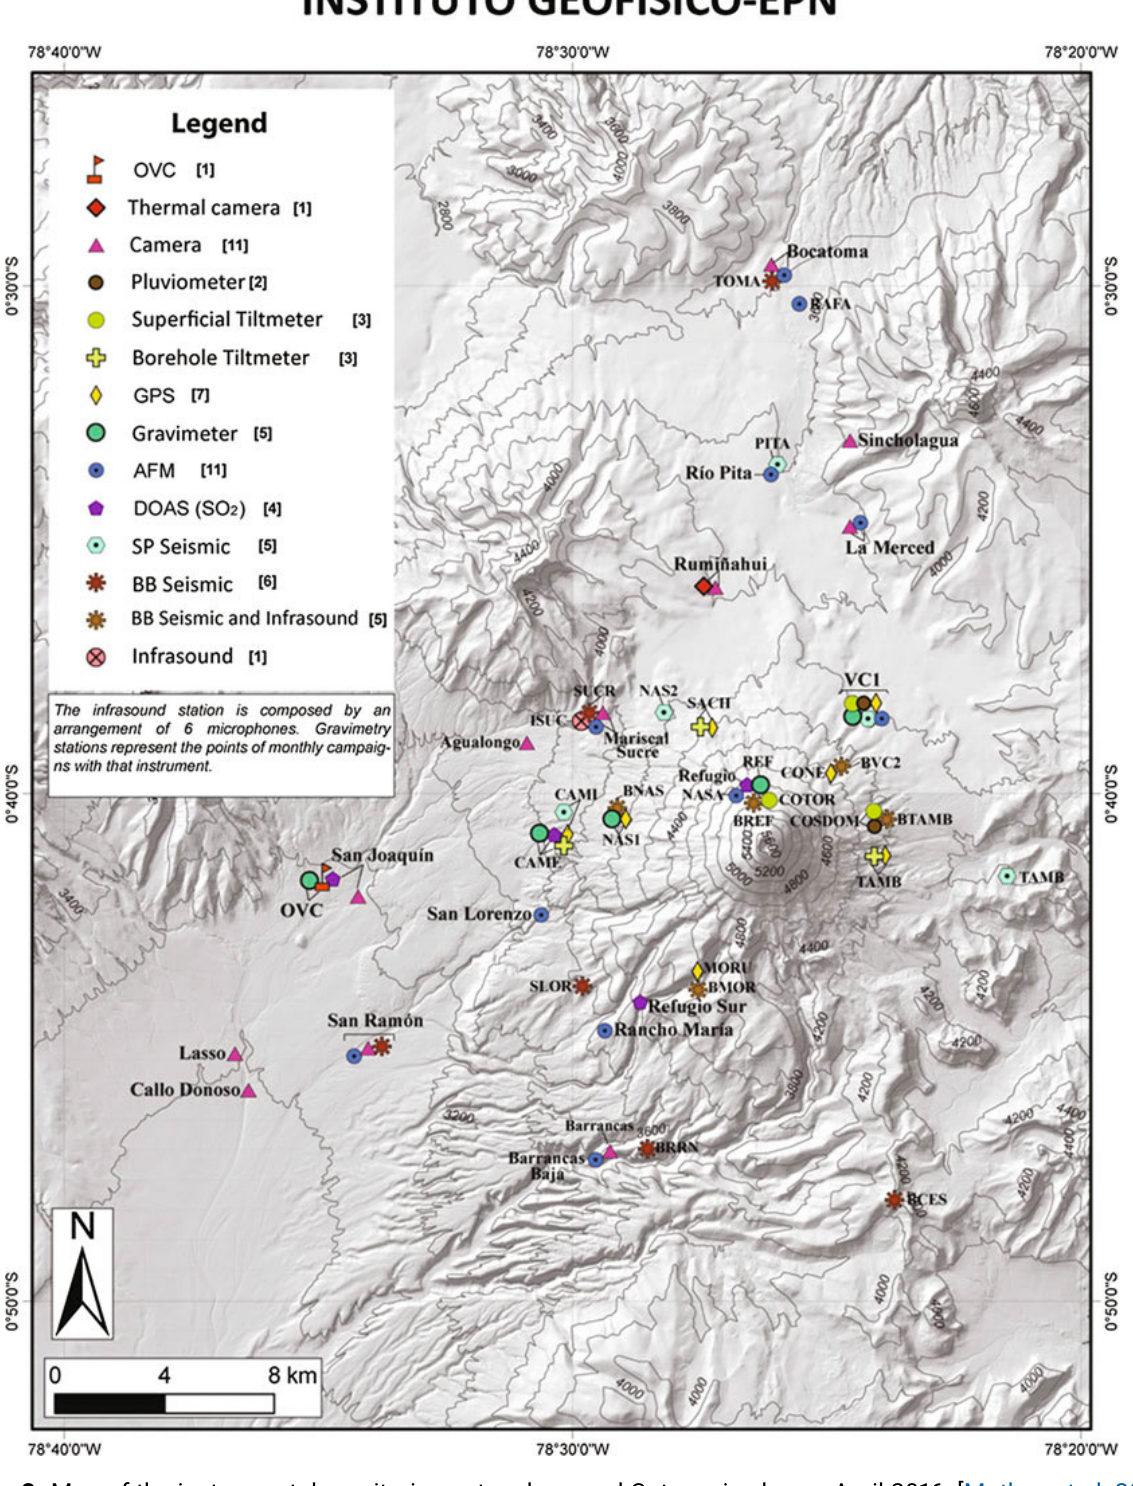
Figure 2: Map of the instrumental monitoring network around Cotopaxi volcano, April 2016 [Mothes et al. 2017]. The station name codes are included. Acronyms: OVC = Observatory Vólcan Cotopaxi, GPS = Geographic Po- sitioning System, AFM = Acoustic Flow Meter, DOAS=Differential Optical Absorption Spectroscopy, SO Dioxide, SP = Short Period seismometer, BB = Broad Band seismometer.